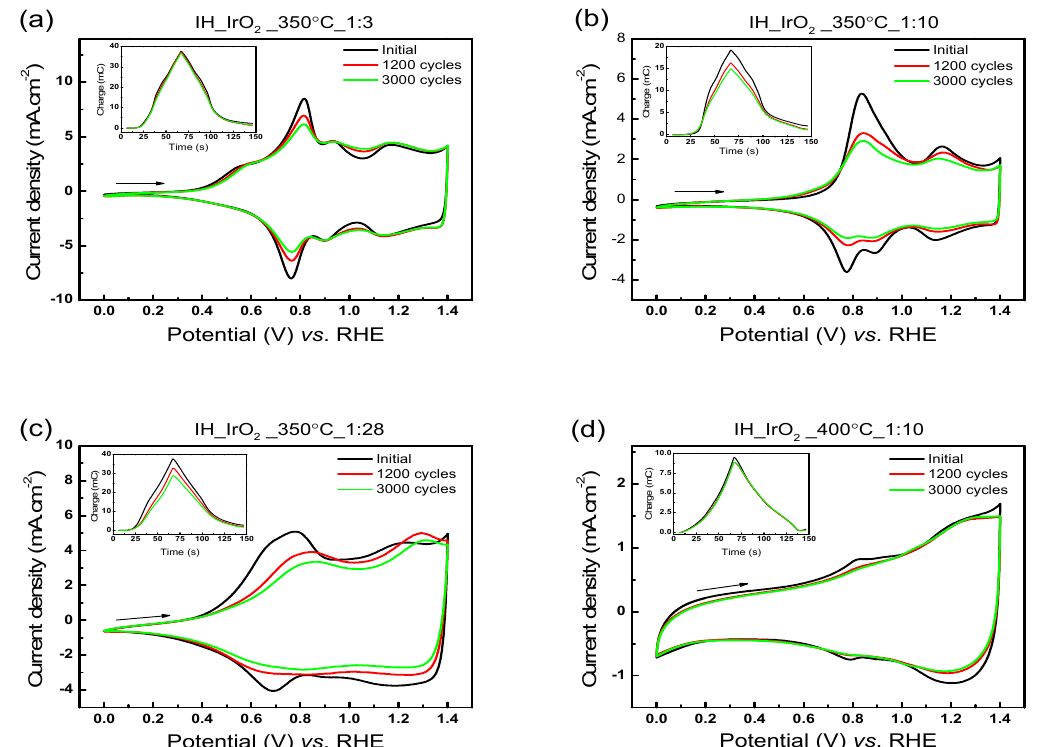
Figure 7. Durability CV analyses of the in-house IrO 2 samples at 20 mV · s − 1 potential scan rate. ( a ) IH_IrO 2 _350 °C_1:3, ( b ) IH_IrO 2 _350 °C_1:10, ( c ) IH_IrO 2 _350 °C_1:28 and ( d ) IH_IrO 2 _400 °C_1:10. Insets are the charge vs. time plots.